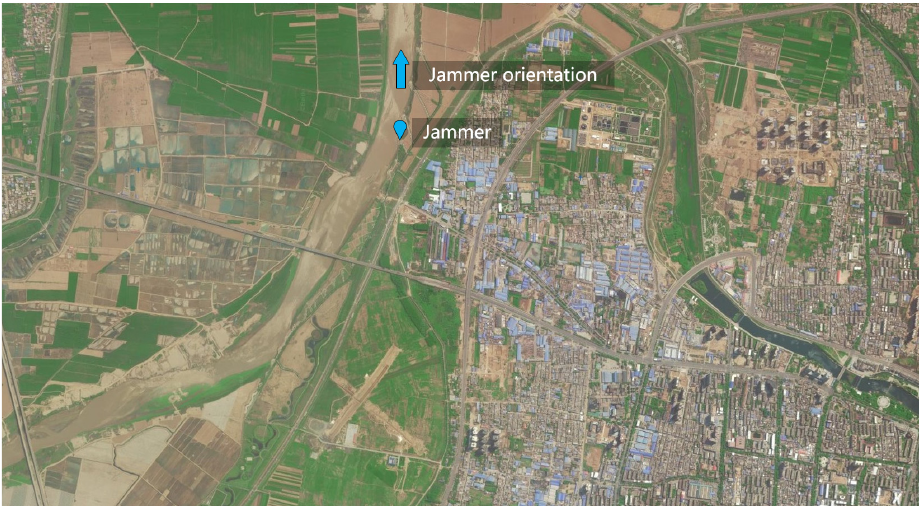
Figure 12. Optical image of the imaging area and the location and orientation of the jammer.